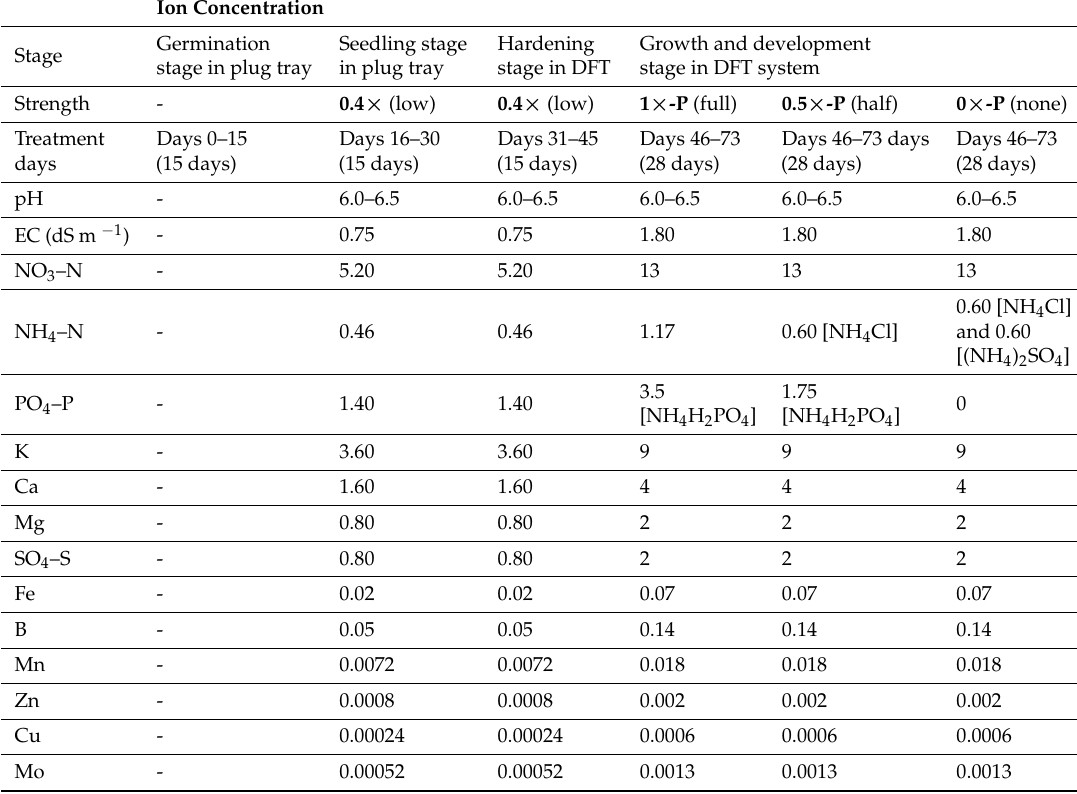
Table 1. Nutrient solution characteristics of low strength ion concentration (0.4 × ) in the seedling stage in the plug tray and the hardening stage in the deep flow technique (DFT), and full (1 × -P), medium or half (0.5 × -P) and no (0 × -P) P ion concentrations at the growth and development stage in the DFT system of hydroponic red romaine